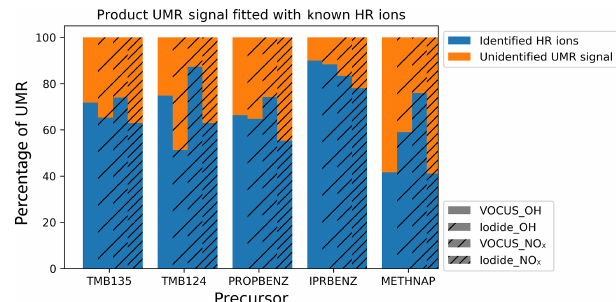
Figure 1. Proportion of the unit mass resolution (UMR) signal fit- ted by identified high-resolution (HR) ions for all precursors and experimental conditions from I-CIMS and